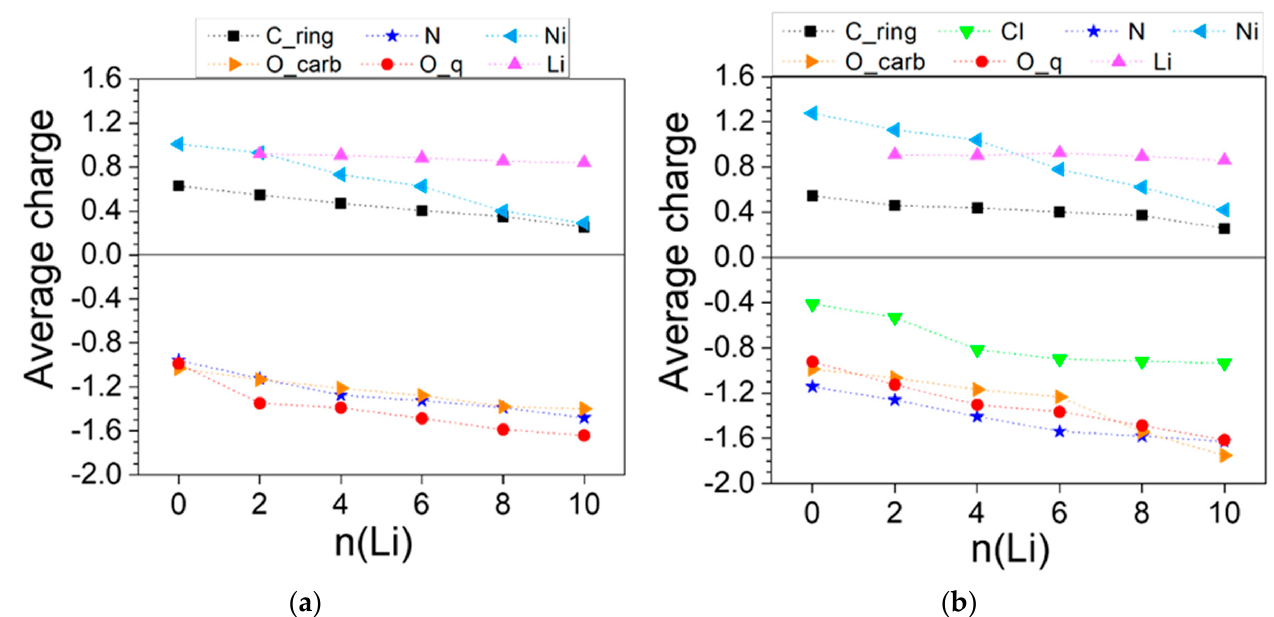
Figure 13. Averaged AIM charges in the lithiated ( a ) [Ni(II)L3] n and ( b ) [Ni(IV)L3] n . Numerical values can be found in Tables S12 and S13.